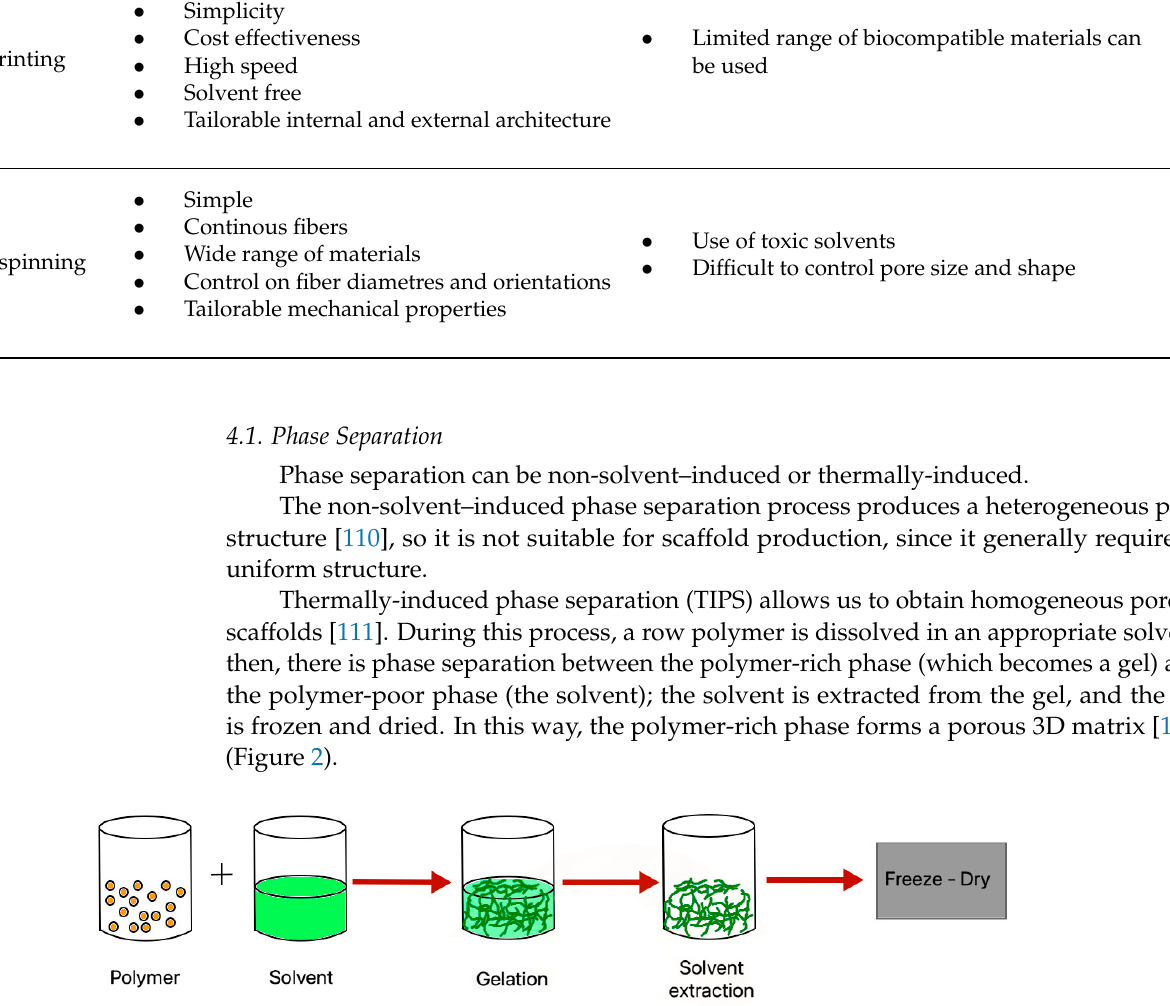
Figure 2. Thermally ‐ induced phase separation